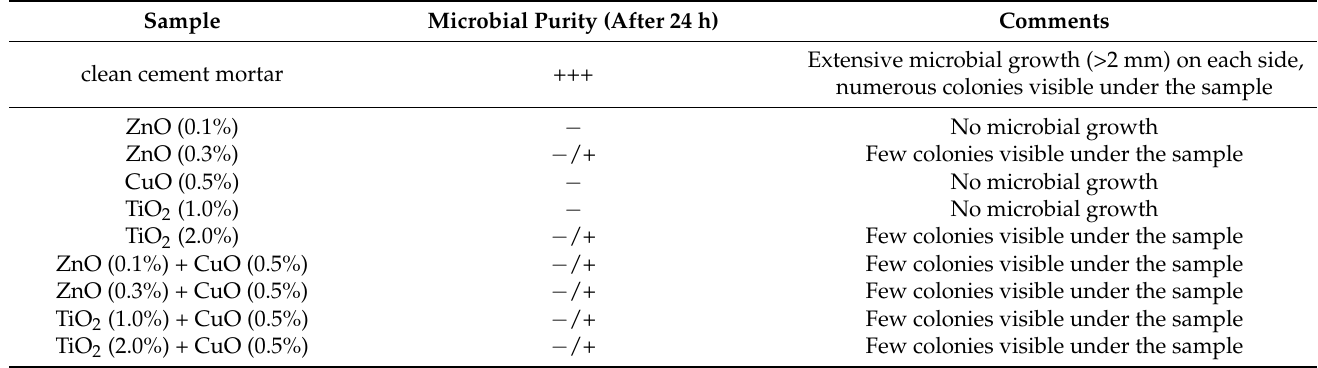
Table 4. Results of microbial purity testing for all